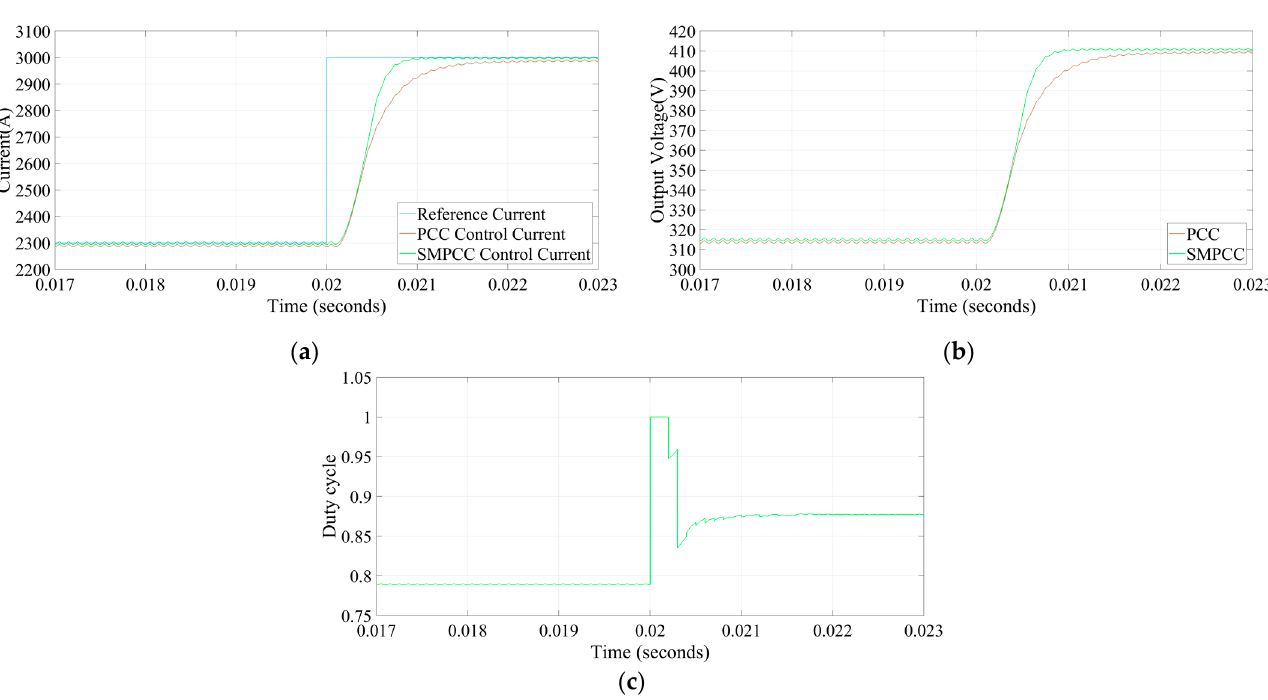
Figure 4. The simulation when output reference current abruptly increases. ( a ) The output current changes; ( b ) The output voltage changes; ( c ) The duty cycle changes of M1 and M4 in SMPCC.